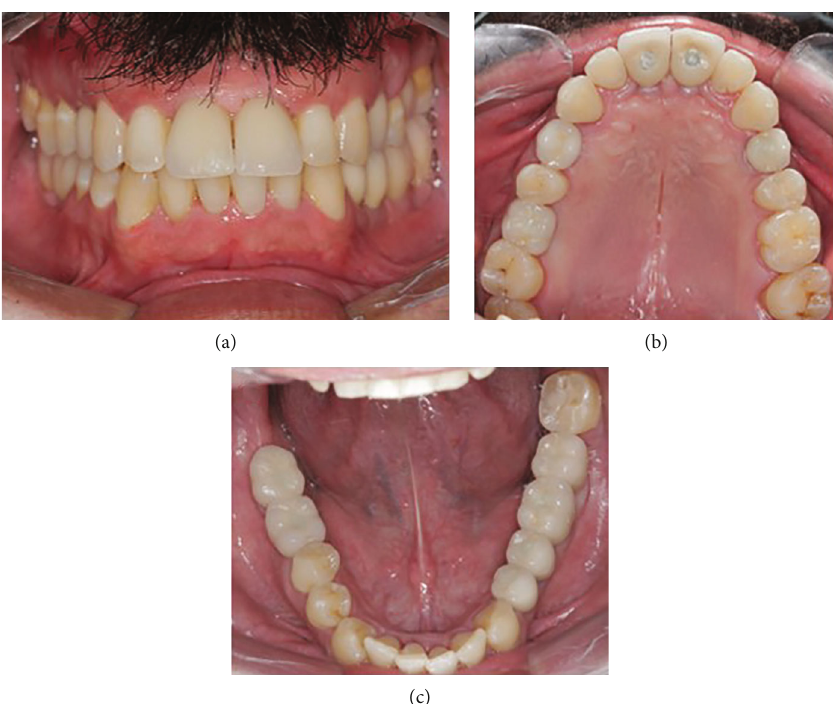
Figure 7: Clinical aspects at 2 years follow-up visit. Frontal view in occlusion (a), maxillary (b), and mandibular (c) occlusal